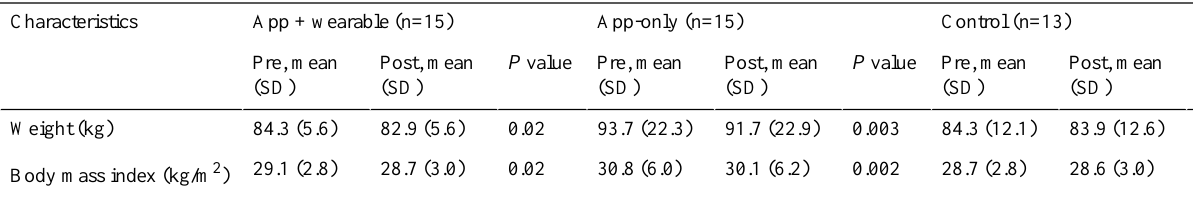
Table 2. Primary outcome changes of each group.